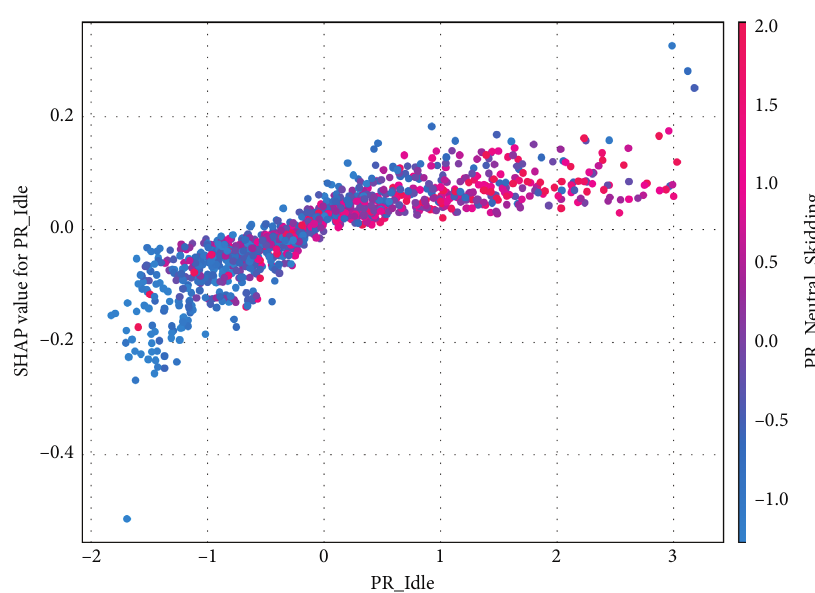
Figure 9: The global impact of idling on fuel